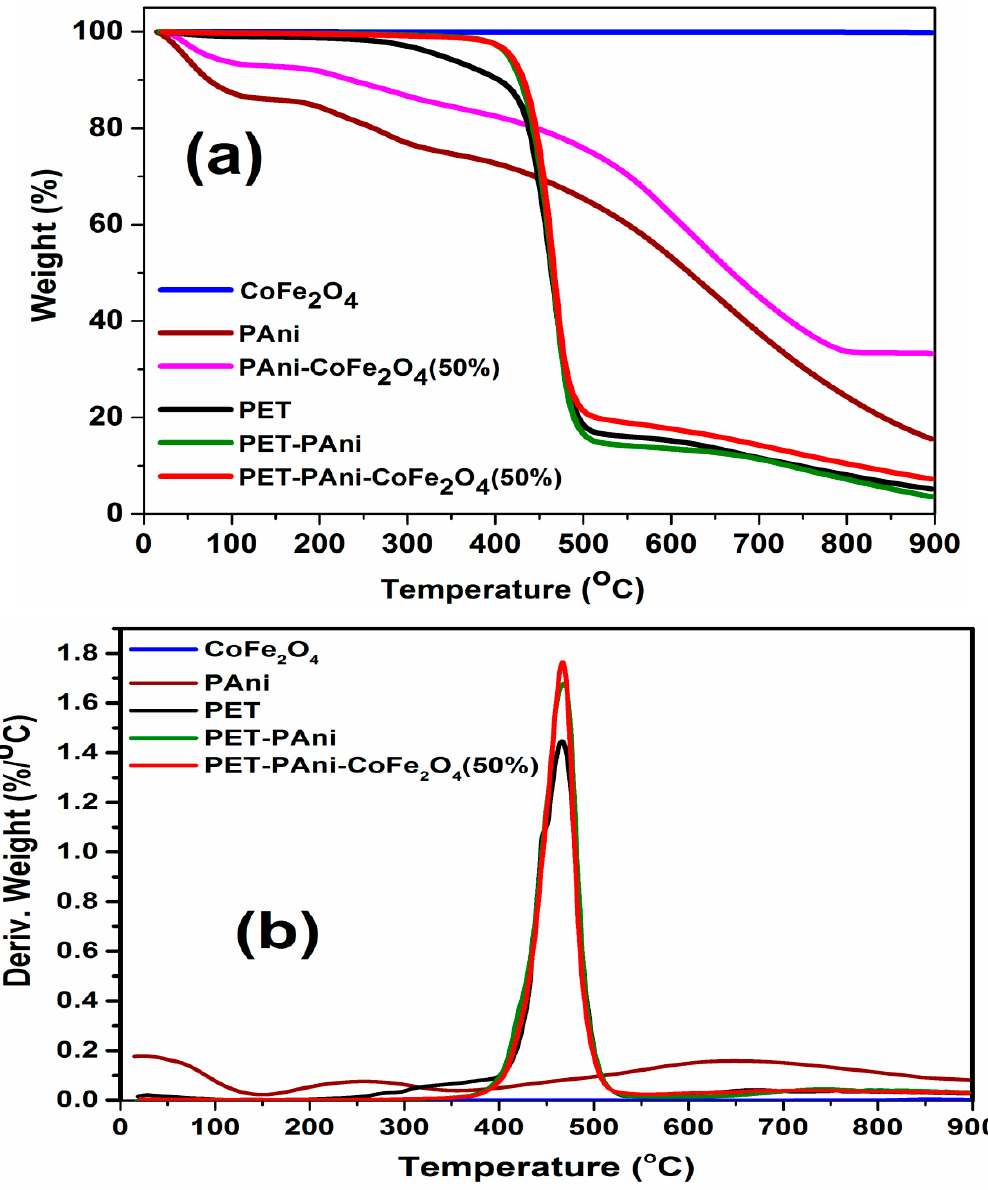
Figure 9. TG ( a ) and DTG curves ( b ) of CoFe 2 O 4 , PAni, PAni-CoFe 2 O 4 (50%) nanocomposite, PET, PET-PAni and PET-PAni-CoFe 2 O 4 (50%).